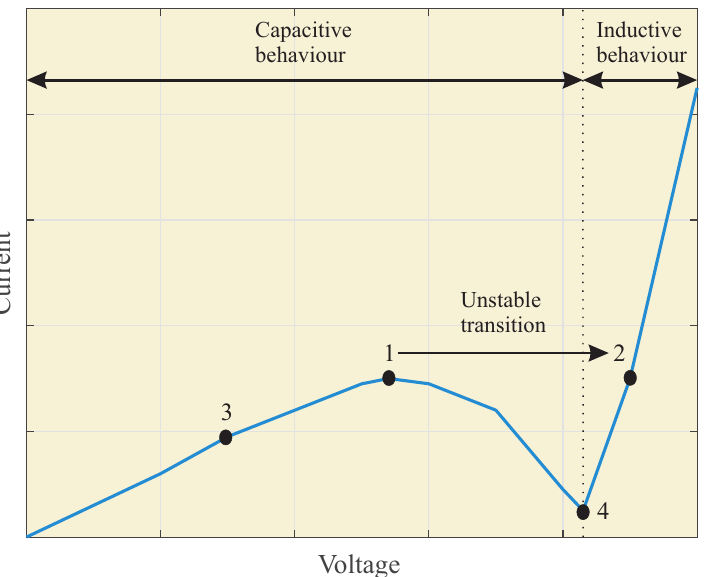
Figure 2. Non-linear behavior of the parallel ferroresonance event in isolated neutral power